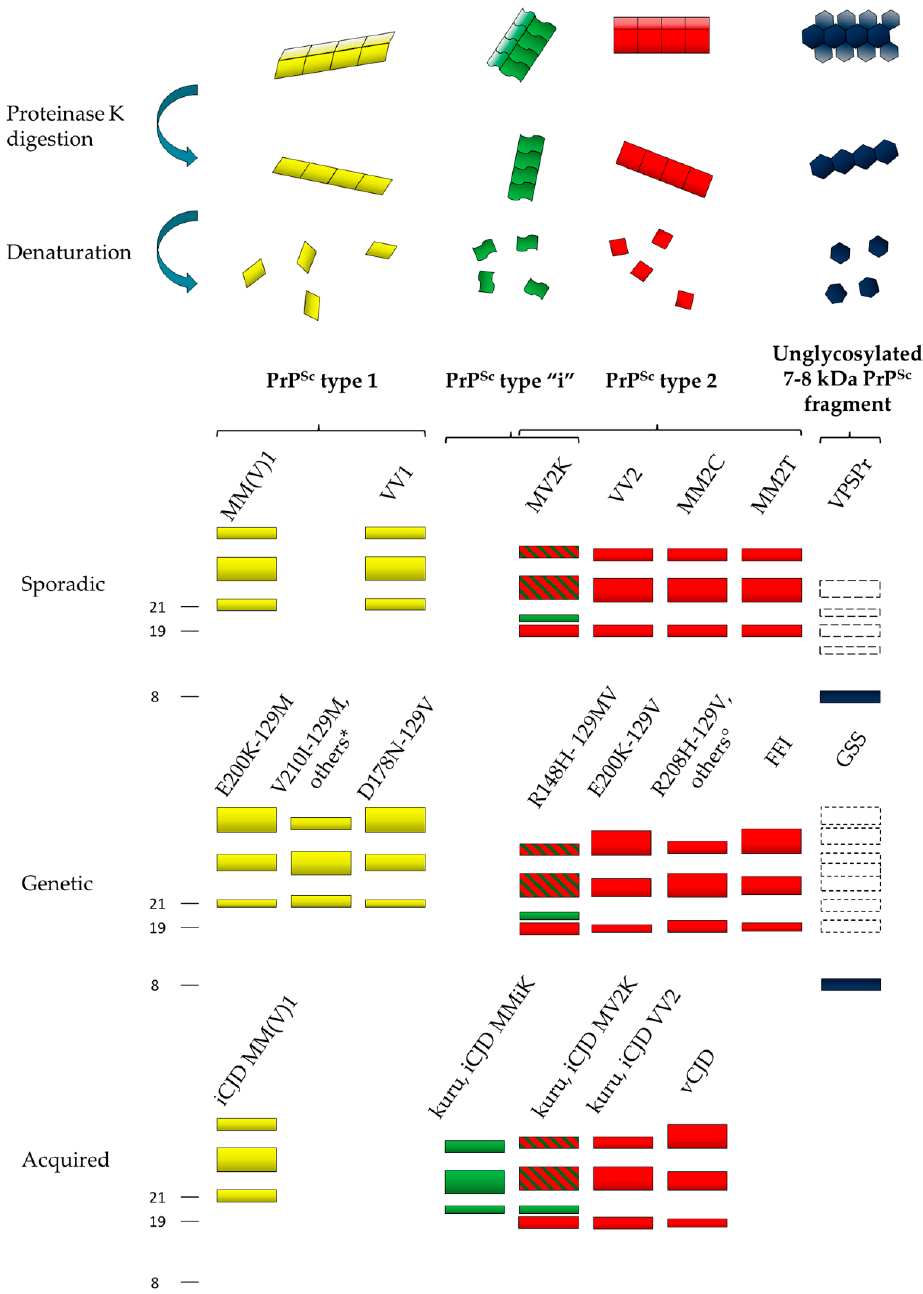
Figure 1. Schematic representation of the heterogeneity of abnormal prion protein (PrP Sc ) aggregates and proteinase K (PK)-resistant core fragments in human prion disease. Four dominant human PrP Sc fragments can be distinguished by sodium dodecyl sulfate (SDS) electrophoresis and immunoblotting after PK digestion and protein denaturation. They include PrP Sc type 1 (21 kDa, in yellow), PrP Sc type “i” (20 kDa, in green), PrP Sc type 2 (19 kDa, in red) and the 7–8 kDa unglycosylated PrP Sc fragments (in dark blue). The bands with dotted lines symbolize PrP Sc fragments that are only occasionally seen. PrP Sc types 1, 2 and “i” comprise a triad of fragments representing, from top to bottom, the diglycosylated, monoglycosylated, and unglycosylated isoforms of the protein. The predominance of the monoglycosylated or diglycosylated band defines “pattern A” or “pattern B”, respectively. The main disease subtypes associated with the four PrP Sc profiles in each etiological disease group (i.e., sporadic, genetic or acquired) are listed. Other mutations include: * PrP Sc type 1: G114V-129M, R148H-129M, D178N-129V, T188K-129M, V189I-129M, E196K-129M, E200K-129M, V203I-129M, R208H-129M, V210I-129M, 2-6 OPRIs–129M; ◦ PrP Sc type 2 196K-129V,